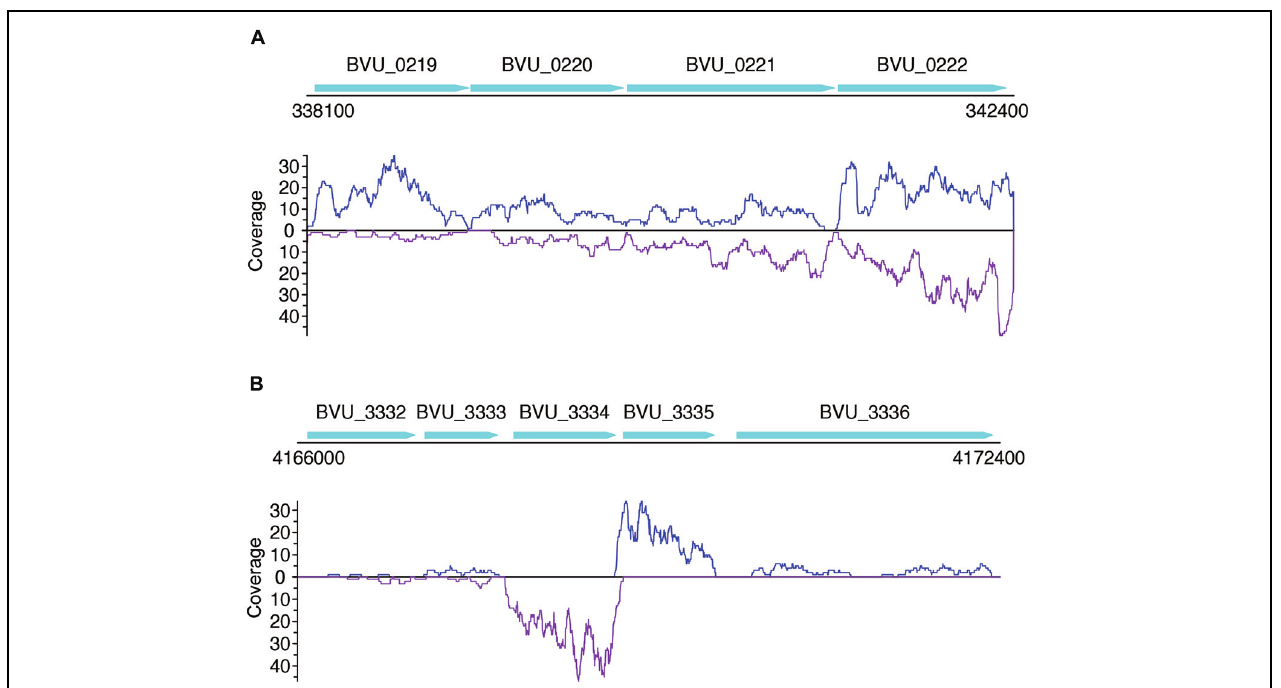
FIGURE 5 | Read coverage plots for example genes in B. vulgatus . Genes are represented as arrows in the plots, and the read coverage curves are shown below the genes, with the coverage for sense and antisense reads shown in blue and purple, respectively. (A) Read coverage plot for an operon with four genes, shown as cyan arrows on the top: BVU_0219 is a putative aldo/keto reductase, BVU_0220 is a hypothetical protein, BVU_0221 is a putative fucose permease, and BVU_0222 is a putative sorbitol dehydrogenase. (B) Read coverage plot for BVU_3334 (and its neighboring genes): BVU_3334 is a putative transcriptional regulator, BVU_3333 is similar to a fructose-6-phosphate aldolase from E. coli , BVU_3332 is a putative ABC transporter permease, BVU_3335 is a hypotentical protein, and BVU_3336 is a putative glycosyl transferase.